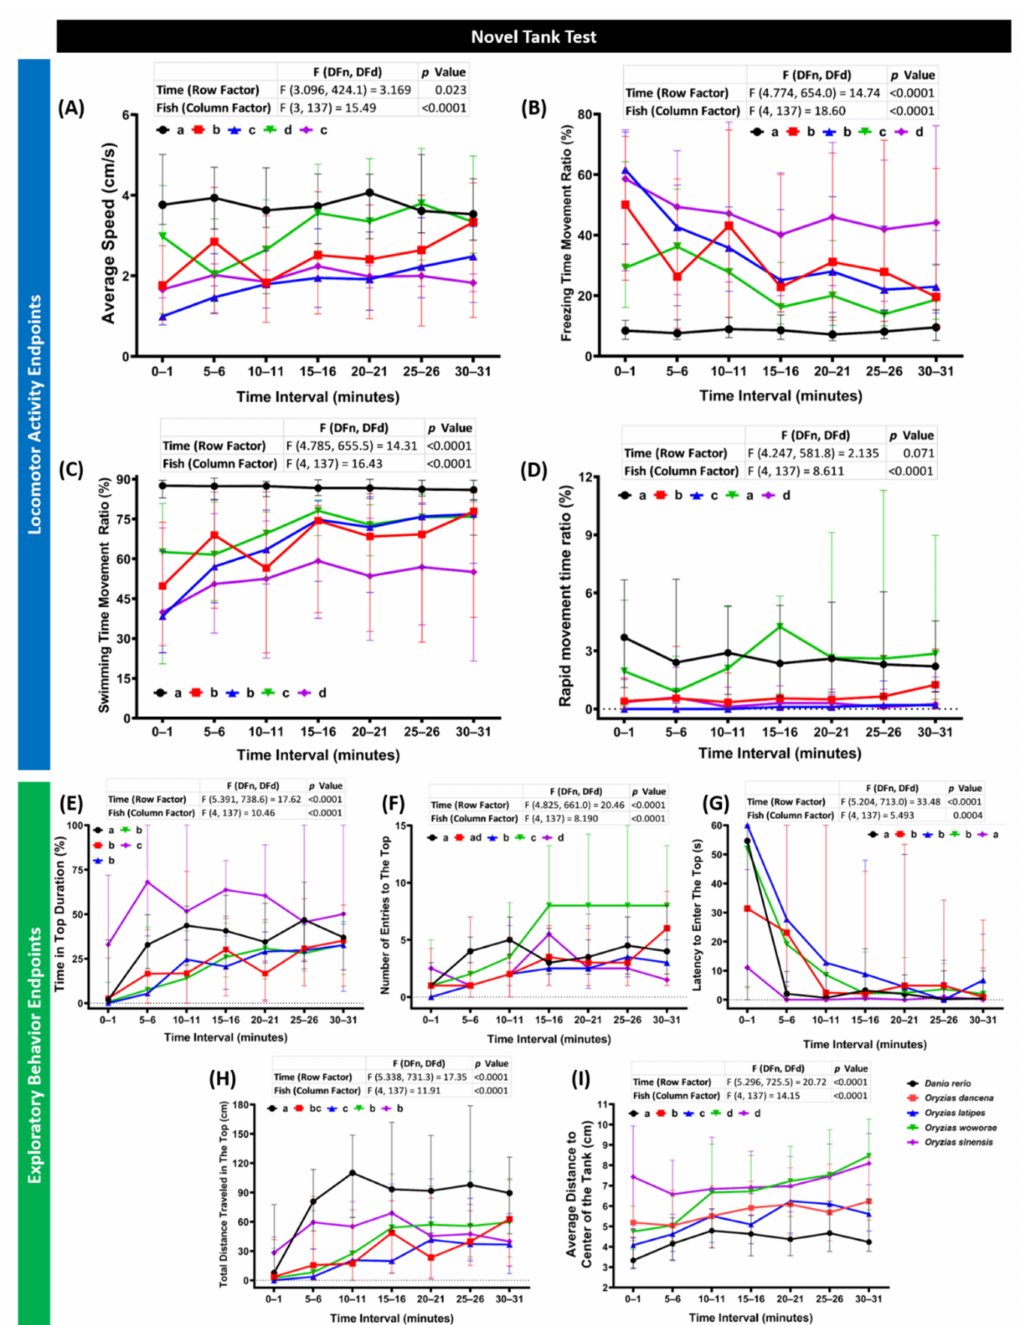
Figure 1. Novel tank behavior endpoints comparison between each tested fish species (medaka and zebrafish). ( A ) Average speed, ( B ) freezing time movement ratio, ( C ) swimming time movement ratio, ( D ) rapid movement time ratio, ( E ) time in top duration, ( F ) number of entries to the top, ( G ) latency to enter the top, ( H ) total distance traveled in the top, and ( I ) average distance to the center of the tank were analyzed. The data were analyzed by the two-way ANOVA test with Geisser–Greenhouse correction continued with uncorrected Fisher’s LSD test. Different letters (a, b, c, d) on the error bars represent a significant statistical difference ( p < 0.05). The data are expressed as the median with interquartile range ( n = 30 for zebrafish, O. dancena , O. latipes , and O. woworae ; n = 22 for O. sinensis